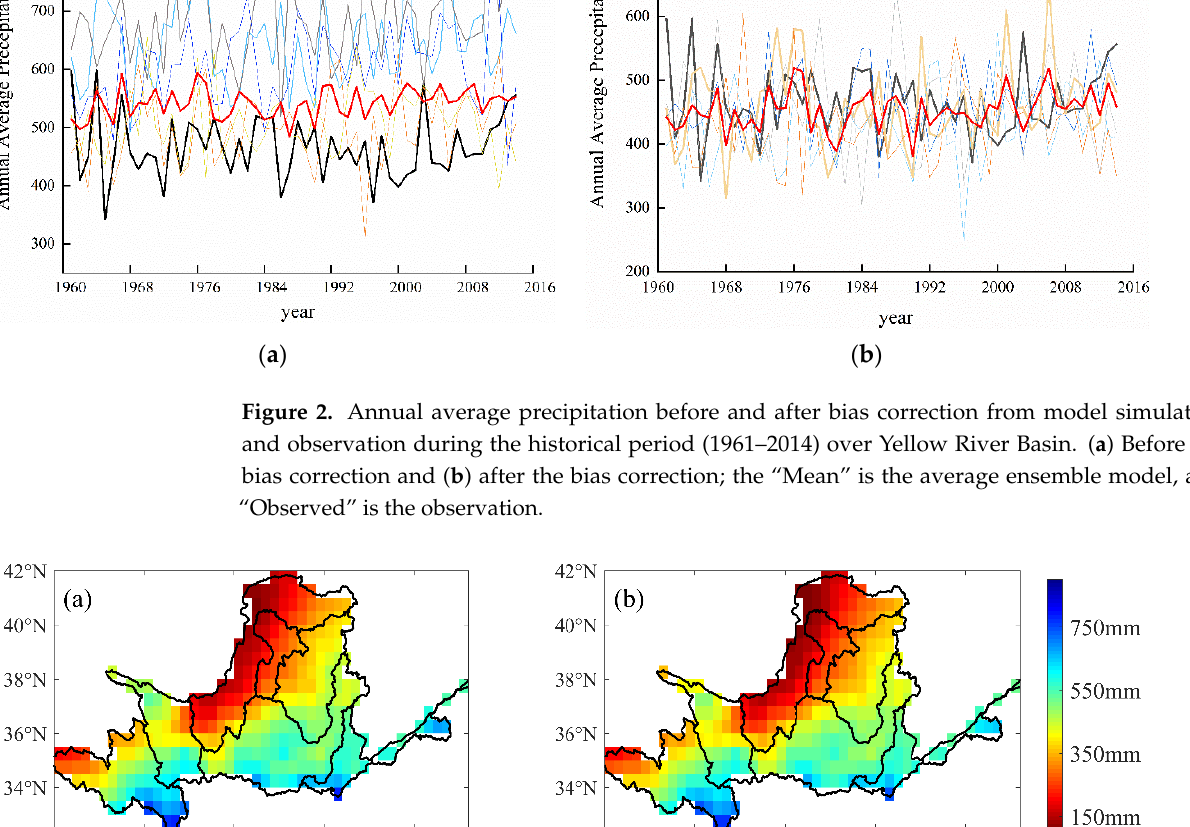
shown in Figure 5. The results indicated the simulation deviations of drought duration, intensity, trend, and drought frequency between the raw products and observed data are 9.12%, − 2.14%, 6.3%, and 14.3%. However, the simulation deviations of drought duration, intensity, trend, and drought frequency are divided into 6.74%, 2.48%, 0.3%, and 1.6%, which means the corrected product performs better in reproducing the variation characteristics of meteorological drought in the Yellow River Basin. Therefore, the corrected GCMs could be applied to the further study. Figure 5. The drought characteristics of raw GCMs, corrected GCMs, and observed data; ( a ) Drought Duration,( b ) Drought Tendency, ( c ) Drought intensity,( d ) Drought frequency. The “D”, ”T”, ”S”, and ”F” is drought duration, drought intensity, drought trend, and drought frequency, respectively. The “sim” means the corrected GCMs; the “obs” means the observed data.